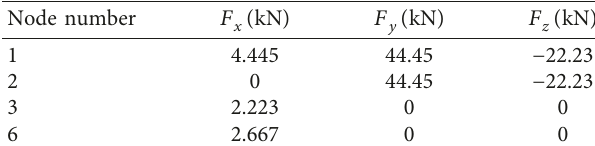
Table 4: 25bar space truss load.